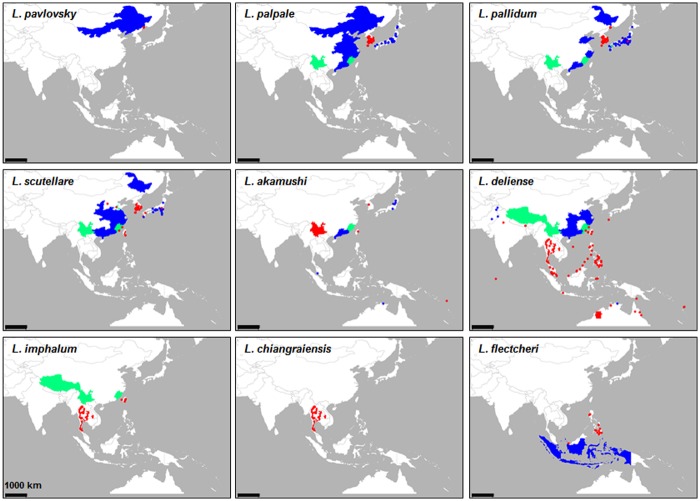
Geographical distribution of nine Leptotrombidium species, the major vectors of scrub typhus.Geographical distributions of nine representative Leptotrombidium species mediating scrub typhus are presented. If the collection sites of vector identification were specified with coordinates, they are indicated as red dots, otherwise the collection sites were indicated at province or county level as colored area. Blue: collected before 1974, red: collected after 1974, green: collected before and after 1974. Detailed information is available in S3 Table.